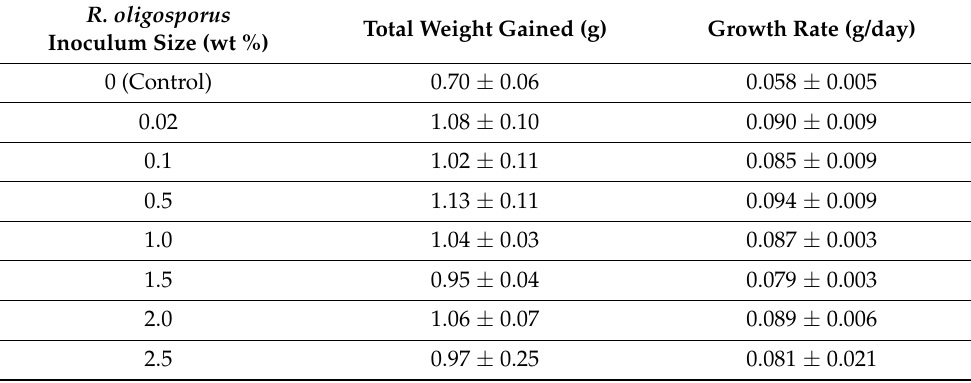
Table 2. Growth performances of BSFL fed with ex situ fermented CEW. Values are mean ± standard deviation ( n =